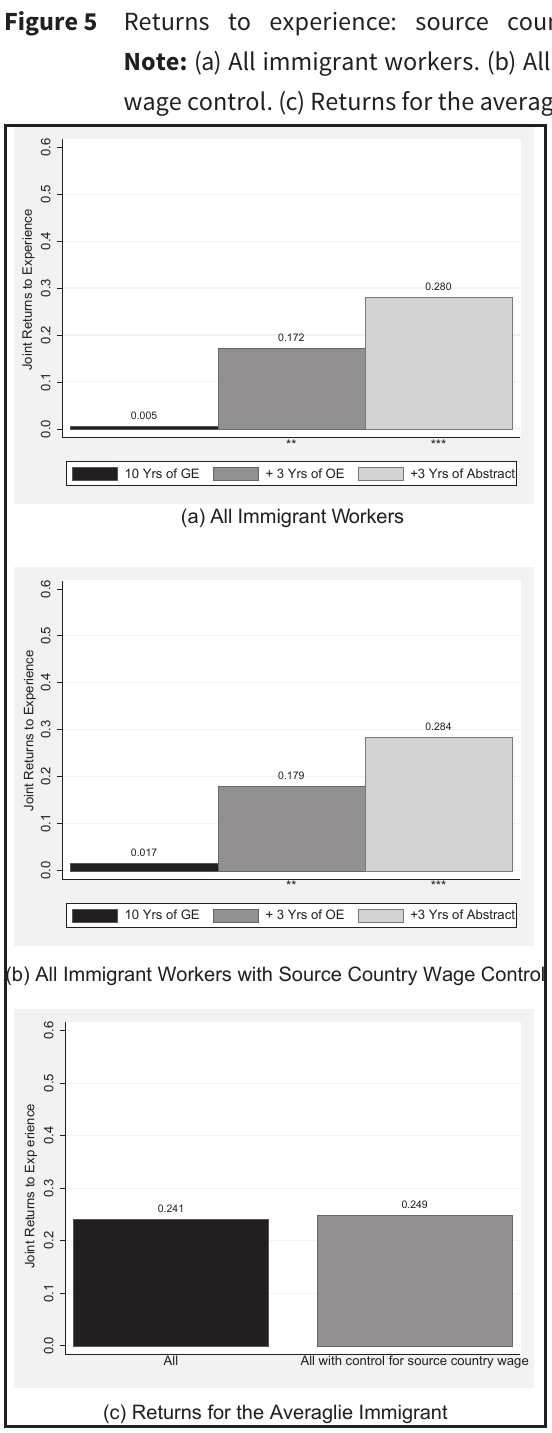
Figure 5 Returns to experience: source country wage sample – two-digit level. Note: (a) All immigrant workers. (b) All immigrant workers with source country wage control. (c) Returns for the average